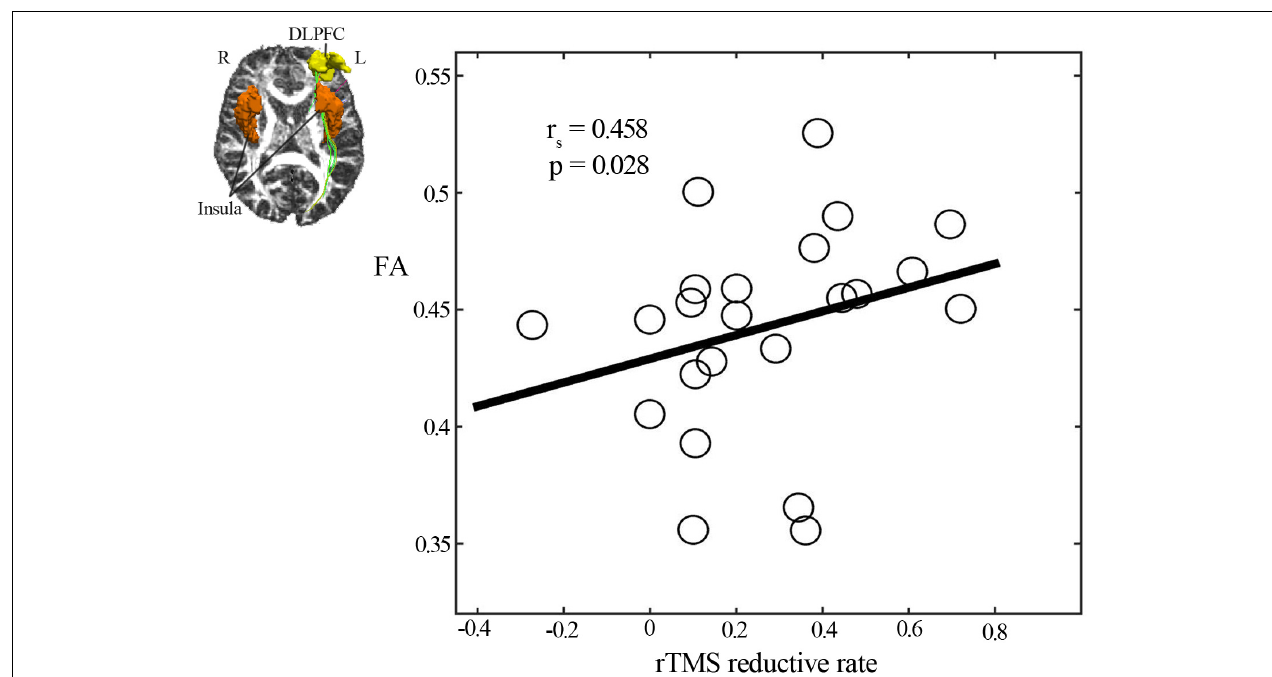
FIGURE 4 | Spearman correlation analysis showed a positive correlation of clinical efficacy with the mean FA value of structural connectivity between the left DLPFC and left insular cortex. DLPFC, dorsal lateral prefrontal cortex; FA, fractional